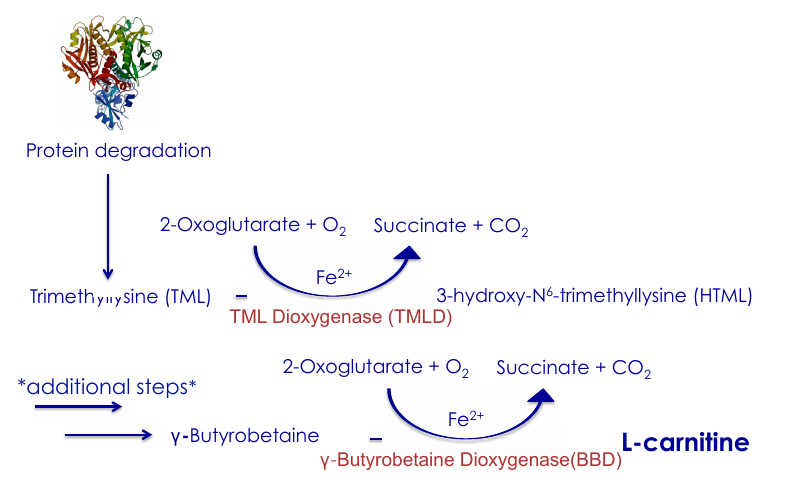
Figure 1. L-carnitine Synthesis. Endogenous L-carnitine synthesis. L-carnitine is biosynthesized from trimethyl-lysine (TML). At least four enzymes are involved in the overall biosynthesis pathway. These are trimethyl-lysine dioxygenase (TMLD), 3-hydroxy-N-trimethyllysine aldolase (HTMLA), 4-N- trimethylaminobutyraldehyde dehydrogenase (TMABA-DH) and ϒ -butyrobetaine dioxygenase (BBD). * The double arrow represents additional steps between HTML and ϒ -butyrobetaine, which are 3-hydroxy-N-trimethyllysine aldolase (HTMLA) that catalyzes 4-N- trimethylaminobutyraldehyde, which then is catalyzed by 4-N-trimethylaminobutyraldehyde dehydrogenase (TMABA-DH) into ϒ -butyrobetaine.